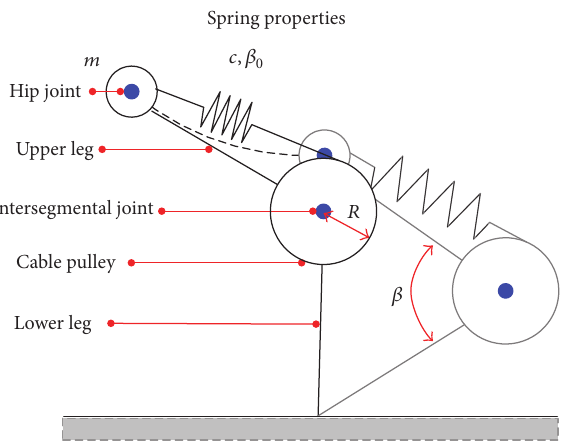
Figure 2: The configuration of the two-segment leg